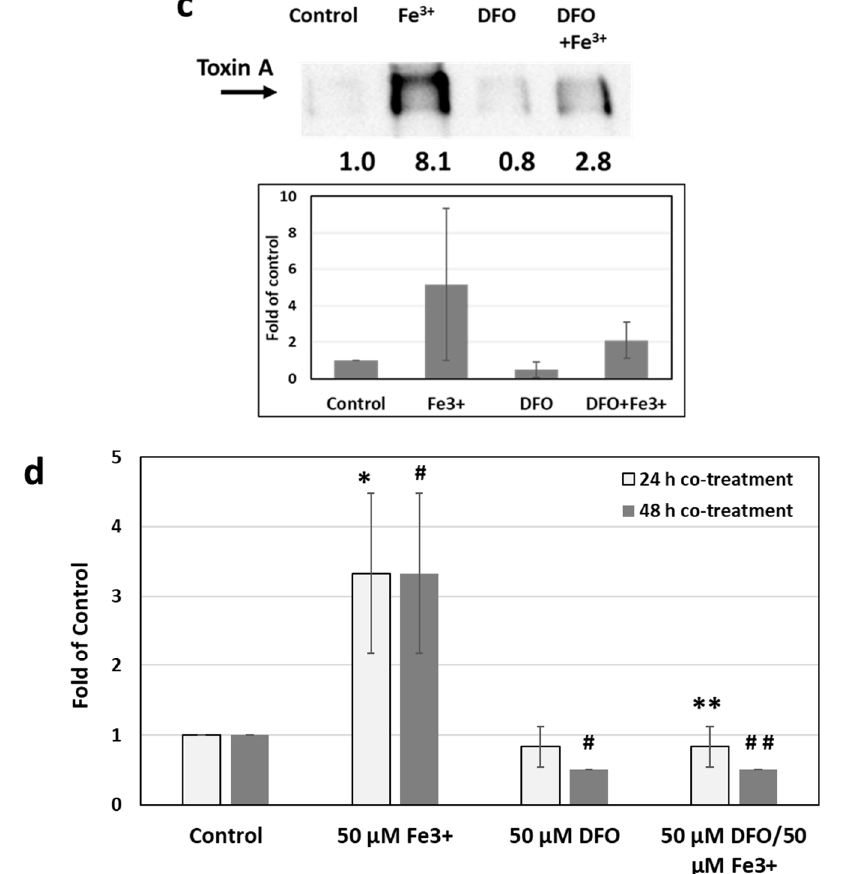
Figure 3. Effects of iron chelators on CDI: ( a ) the iron-chelating activity of deferoxamine (DFO) was determined using the CAS colorimetric assay as described before [32,33]. Reduction in A650 occurs when a strong chelator removes the iron from the chrome azurol sulfate dye. Ferrichrome was used as a positive control; ( b ) decreased colony formation of C. difficile strain 9689 after DFO treatments for 16 h. The results were presented as the average of colonies formed from three plates. *, p < 0.05 compared to vehicle control; ( c ) increased production of C. difficile toxin A after iron exposure was diminished by DFO co ‐ treatment in strain 9689. Concentrated culture supernatant after treatments were subjected to Western Blot analysis. Experiments were repeated at least three times independently and presented as band density (mean ± SD); ( d ) effect of DFO on the susceptibility of C. difficile to metronidazole. The antibiotic susceptibility was determined by the MICs. Each experiment was repeated at least three times independently and presented as mean ± SD. *, p < 0.05 compared to 24 h control; #, p < 0.05 compared to 48 h control; **, p < 0.05 compared to 24 h 50 μ M Fe 3+ ; ##, p < 0.05 compared to 48 h 50 μ M Fe 3+ .